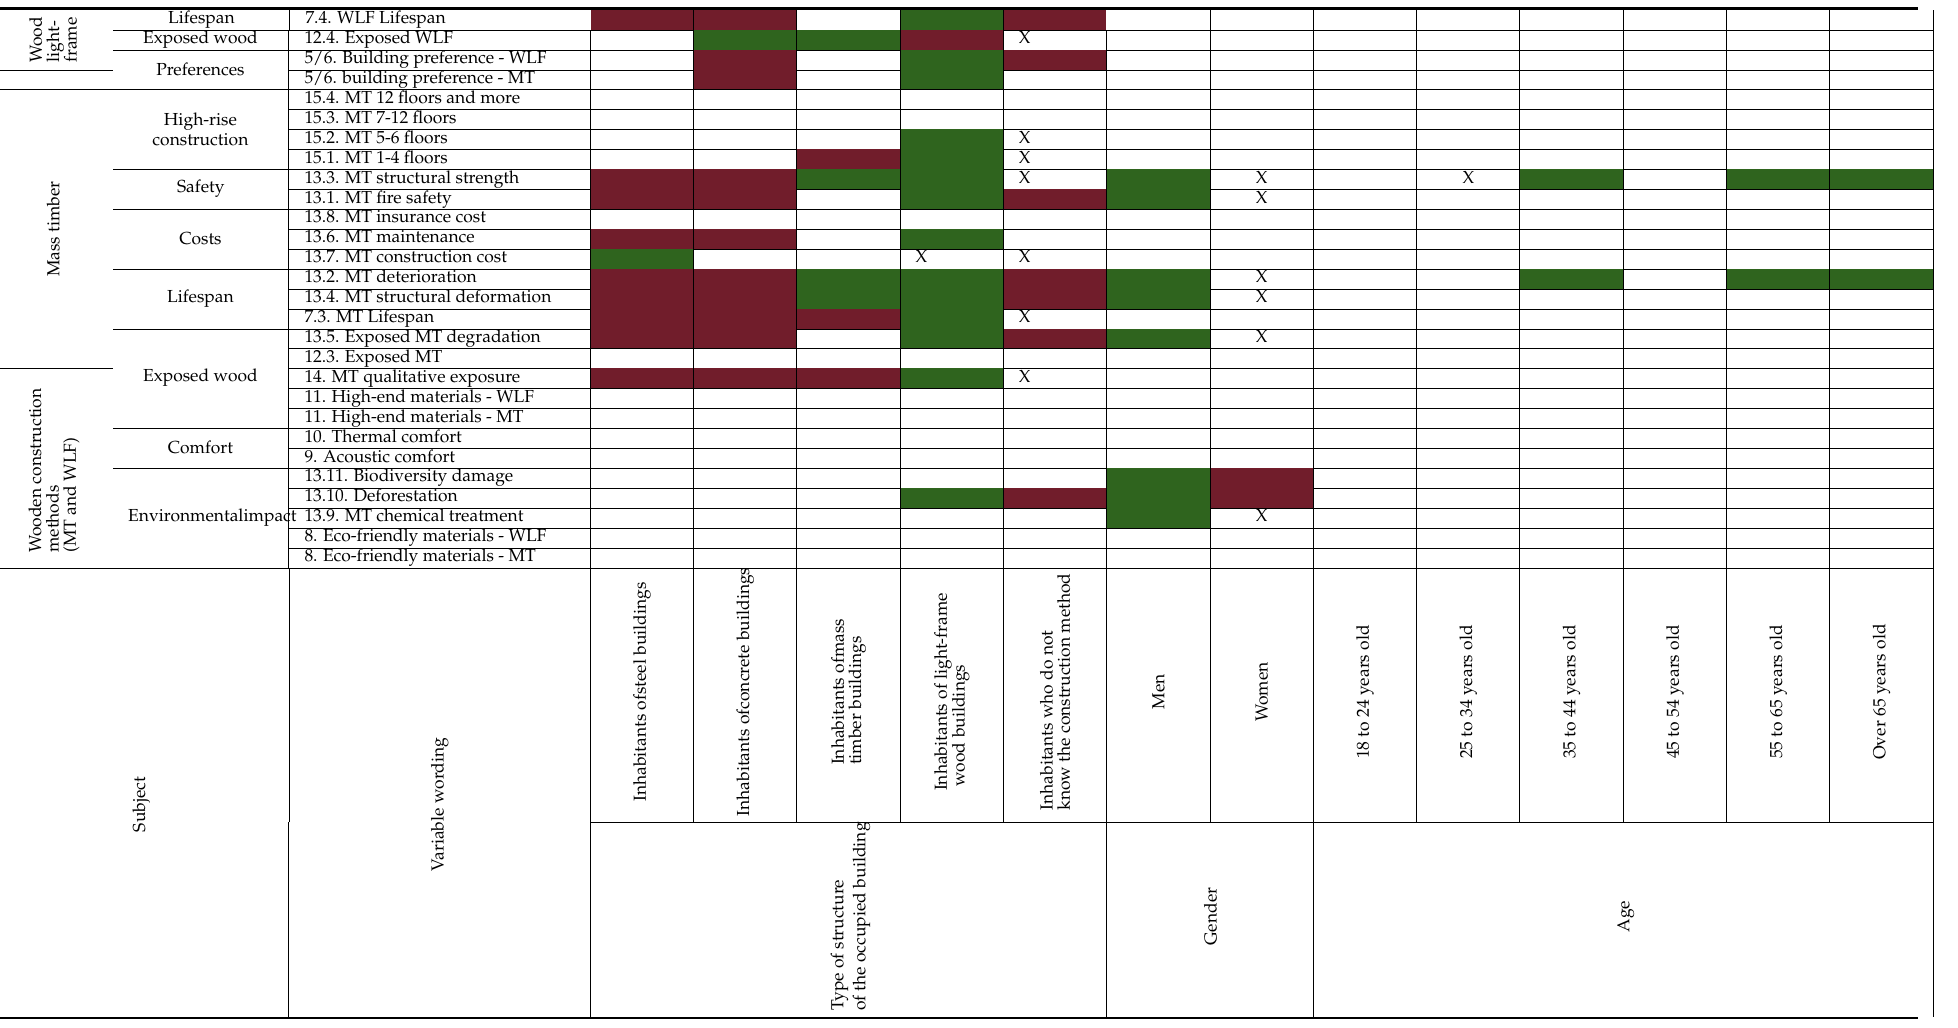
Table 1. Response profile related to respondents’ characteristics regarding wood construction methods. Green cells present a positive perception, red cells a negative perception, and X cells a neutral